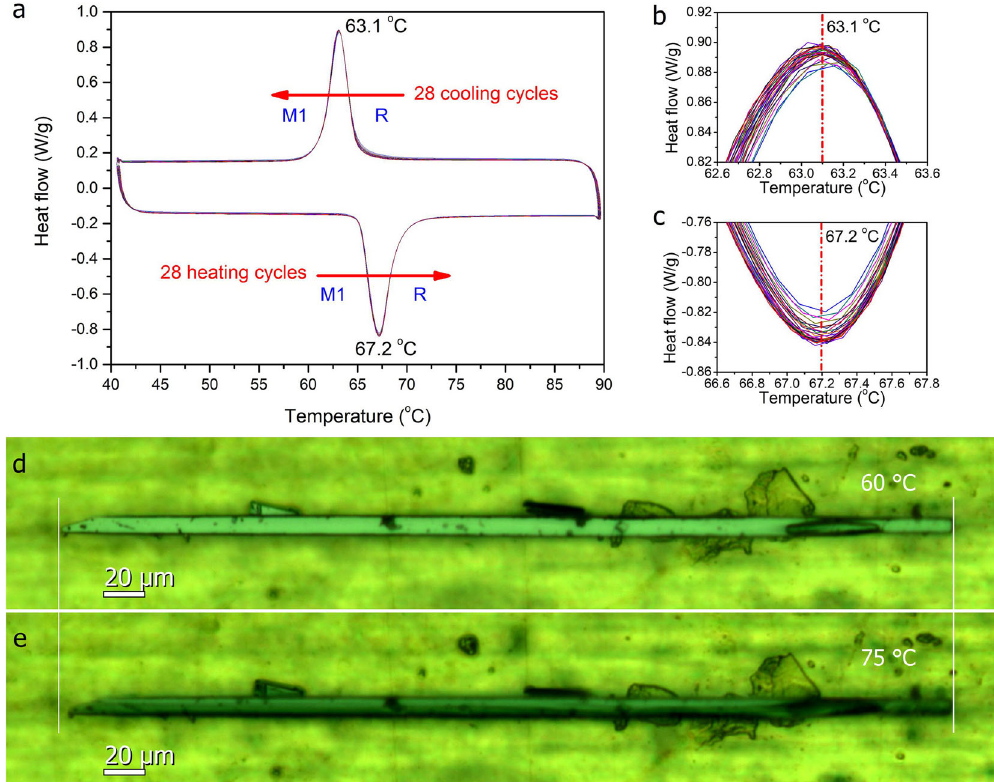
Fig. 3 Phase transition properties of single crystal VO 2 microtubes arrays. a DSC curves during 28 heating and cooling cycles, where 67.2 and 63.1 °C are the peak temperatures for the M1 → R and R → M1 phase transitions, respectively. b Magni fi ed exothermal peaks and c magni fi ed endothermal peaks of DSC curves that demonstrate the excellent thermal cycle stability of single crystal VO 2 microtube arrays. Optical images of an individual single crystal VO 2 microtube in d the M1 phase (60 °C) and e the R phase (75 °C) show not only a clear brightness change but also an obvious length shrinkage of ~0.7% along the [100] M1 ([001] R ) axial direction across the phase transition from the M1 phase to the R phase as marked by the white